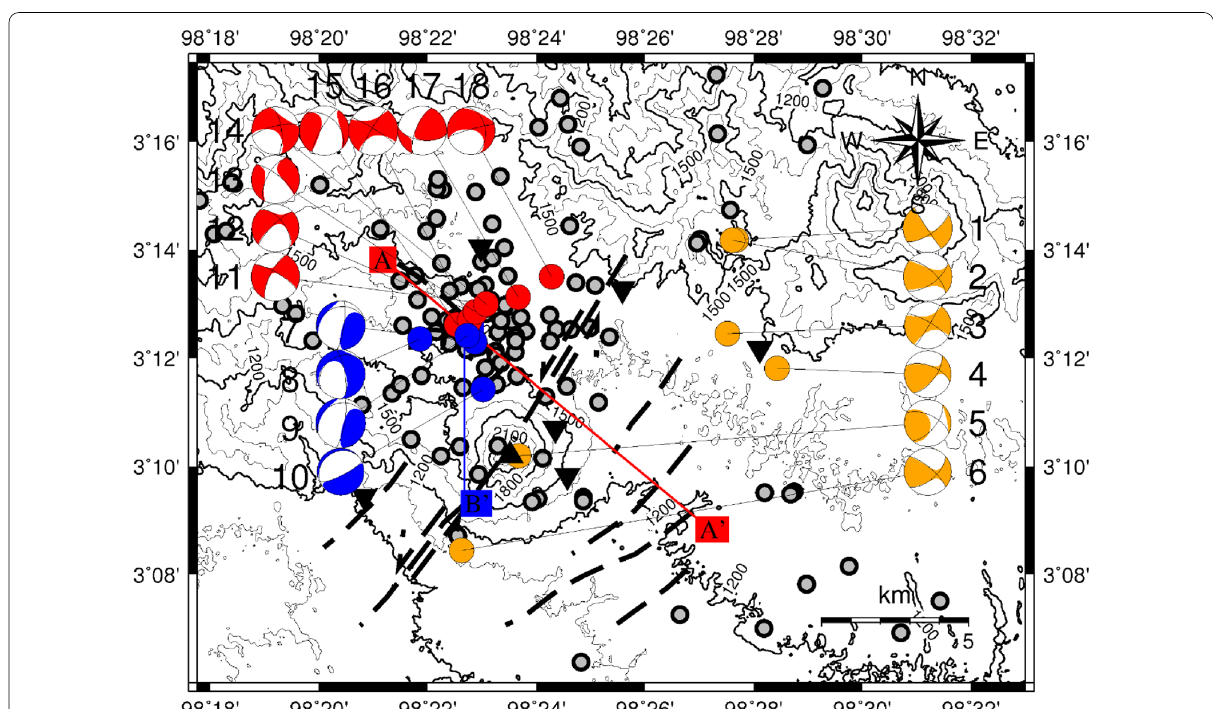
Fig. 5 Plotting the focal mechanism results. There are three groups: the southeast group (orange beach balls), the normal-faulting group